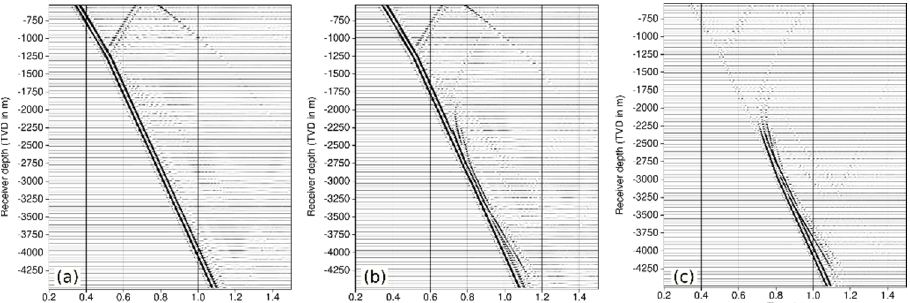
Figure 4. Seismograms showing the seismic effect of the fault. ( a ) synthetic VSP data of the model without the fault. ( b ) synthetic VSP data including the fault. We can mainly identify the scattered fields coming from the fault and crossing the first arrivals at ~−2400 m depth. ( c ) difference between ( a ) and ( b ). The acquisition geometry is identical to that showed in Figure 2, where we show only the data for source located at 0 m offset.